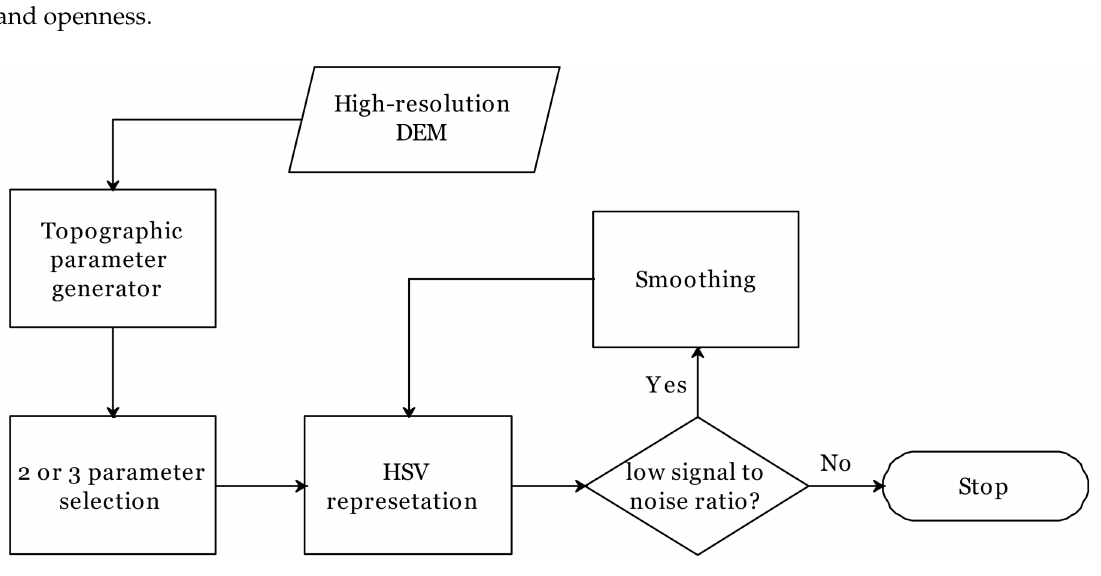
Figure 2. Flowchart of multi-parameter (two-parameter (2P) or three-parameter (3P)) relief mapping in high-resolution digital elevation models